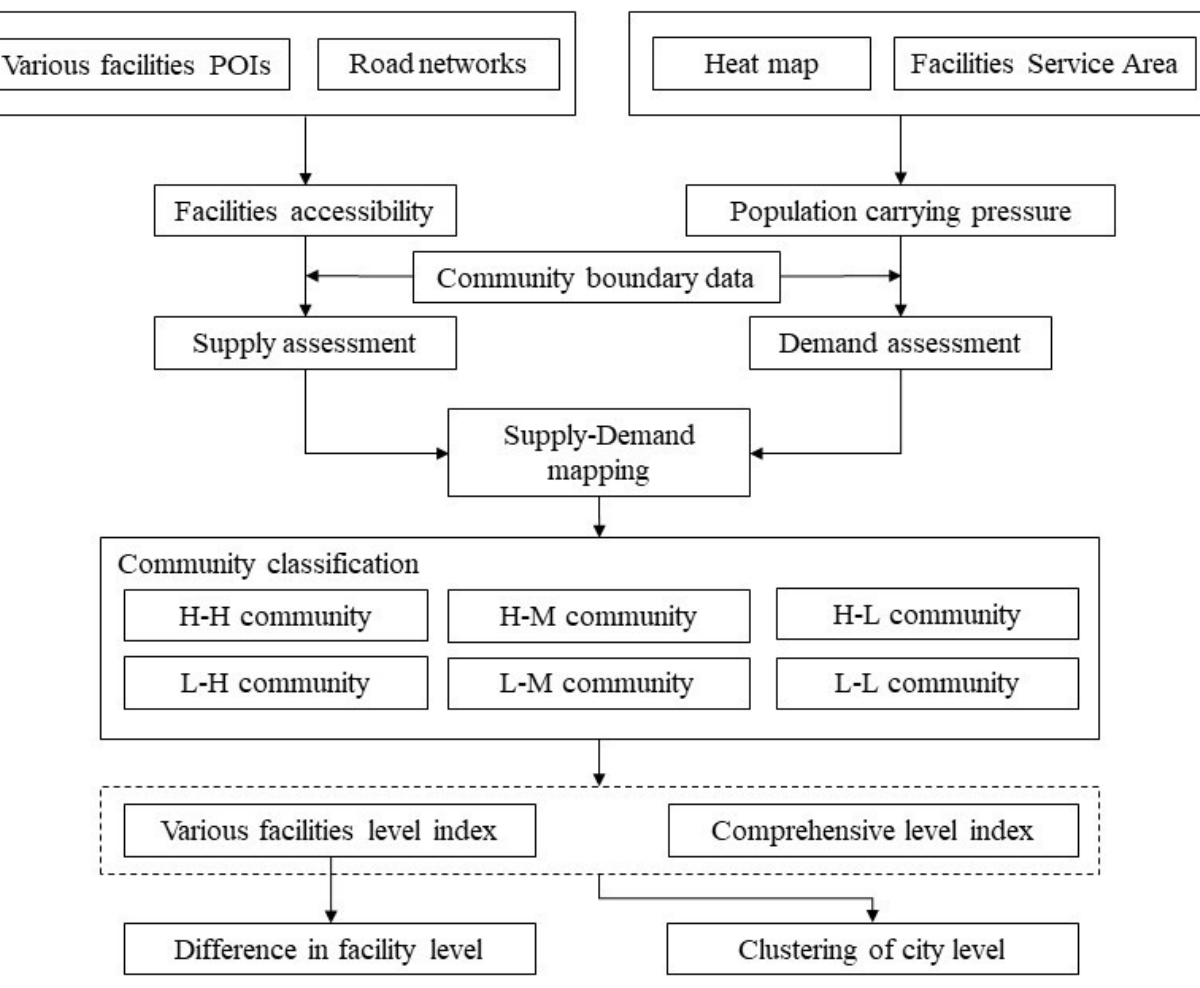
Figure 1. The Integrated framework for the assessment of supply and demand of facilities.